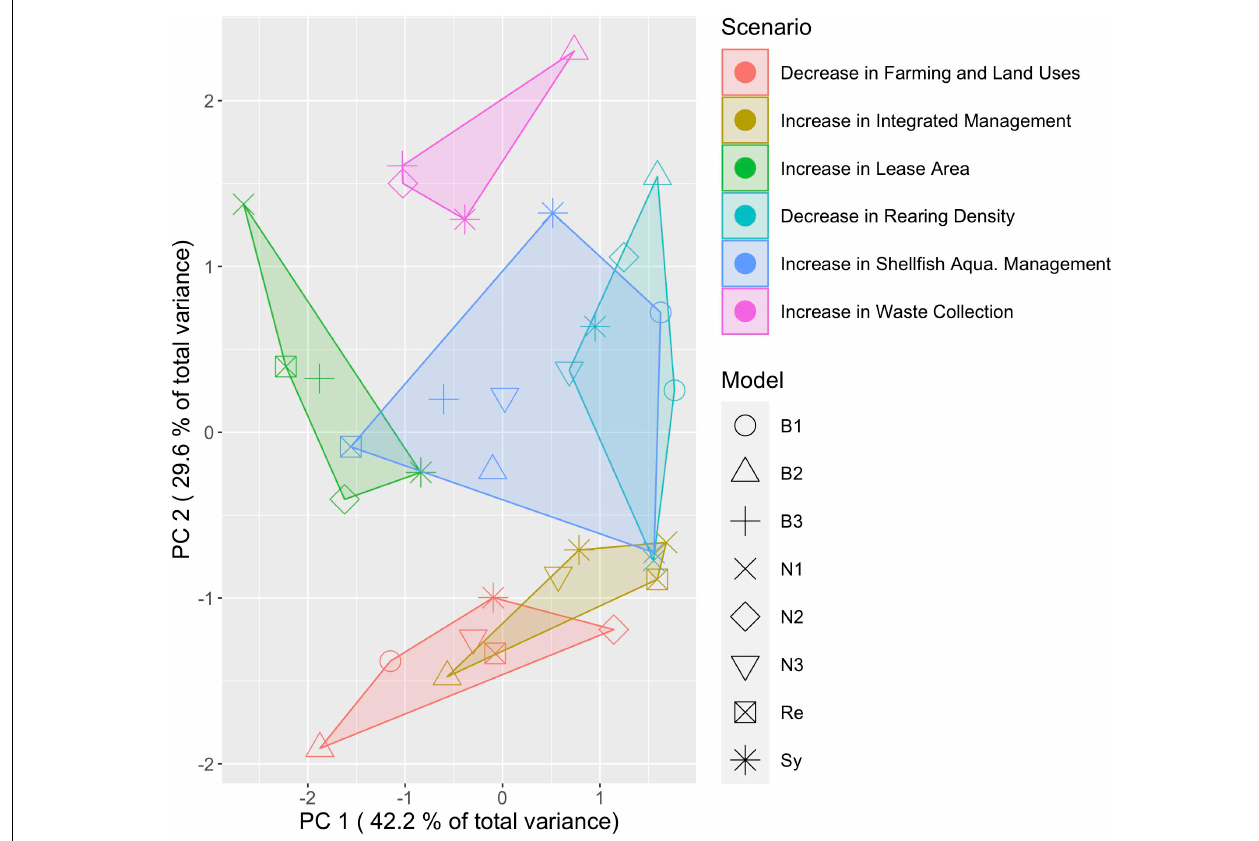
FIGURE 7 | Summary of variability in predictions across alternative models and scenarios. Scores of model predictions across 10 response variables onto the first two PCA axes (that capture ∼ 72% of total variance) reflect consistencies and inconsistencies in predicted qualitative responses to scenarios across models.